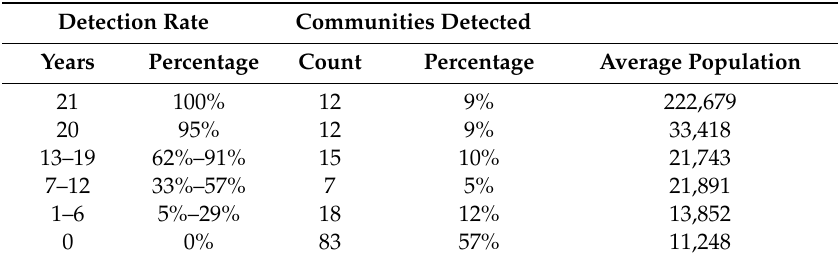
Table 1. Detection rate of communities in Burkina Faso in Defense Meteorological Satellite Program Operational Linescan System (DMSP-OLS) nighttime lights